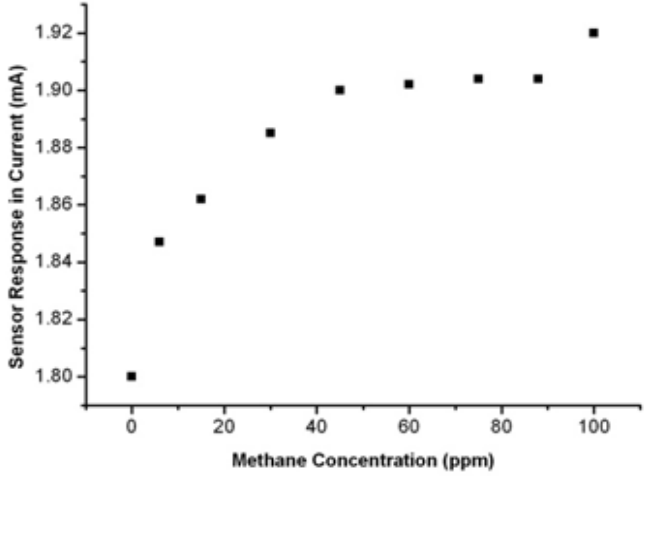
Figure 5. Current response versus concentration of